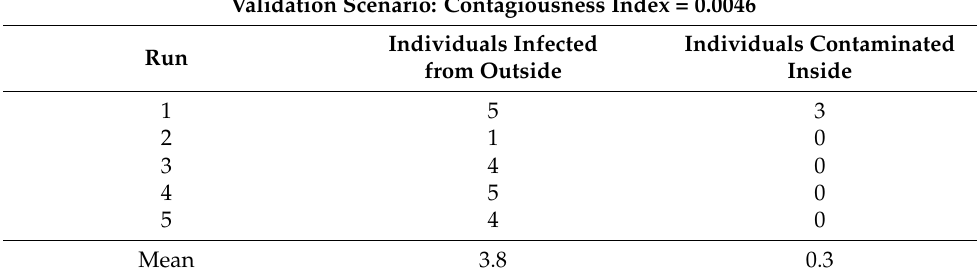
Table 8. Validation scenario